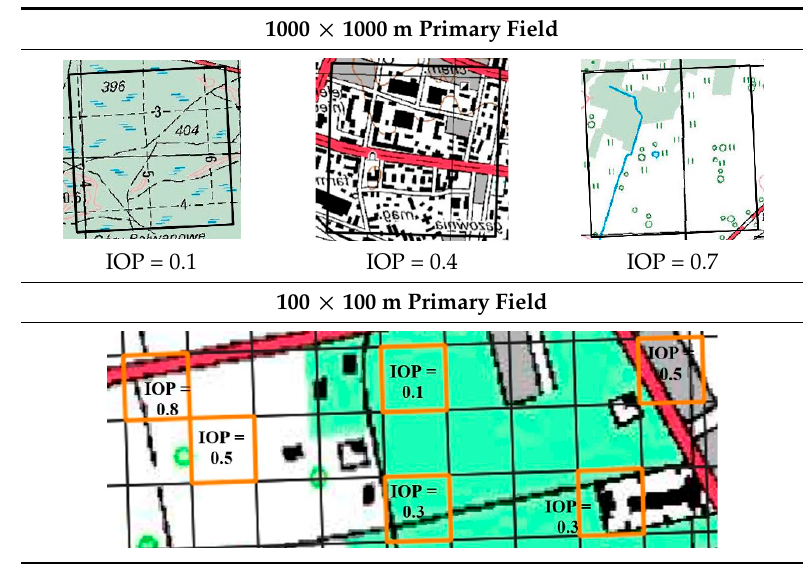
Table 1. Sample values of Index of Passability (IOP) assigned manually by the operator for primary fields 1000 m and 100 m square.